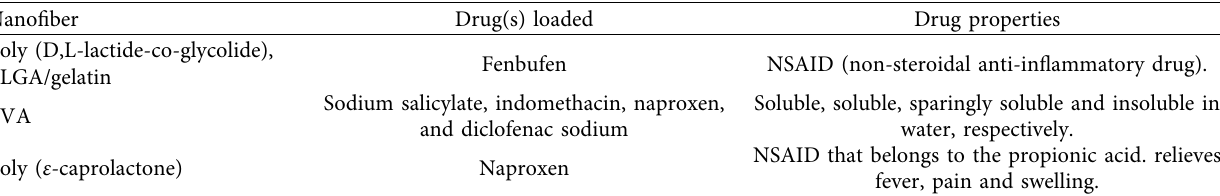
Table 2: Examples of materials used for drug delivery [43, 46,